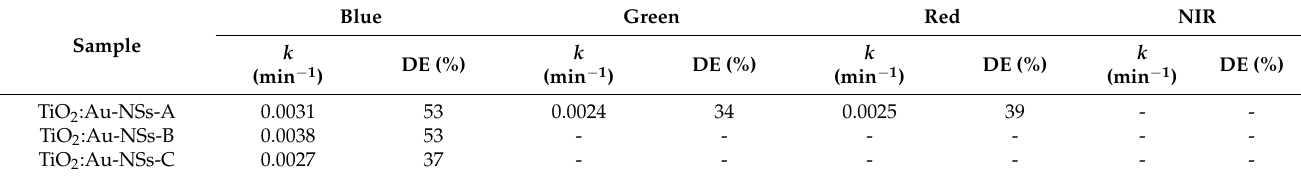
Table 3. CIP degradation efficiencies (DE, %) and corresponding apparent reaction rate constants ( k ) under 150 min blue, green, red and NIR radiation for TiO 2 :Au-NSs-A, B, and C